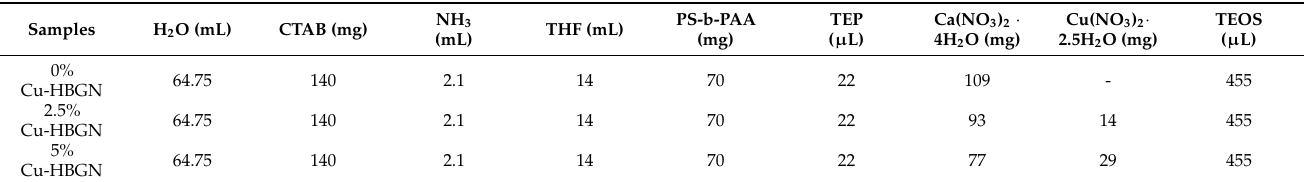
Table 1. Quantities of reagents used. TEP and TEOS were previously dissolved in 1.4 mL of ethanol, while Ca (NO 3 ) 2 · 4H 2 O was dissolved in 1.4 mL of